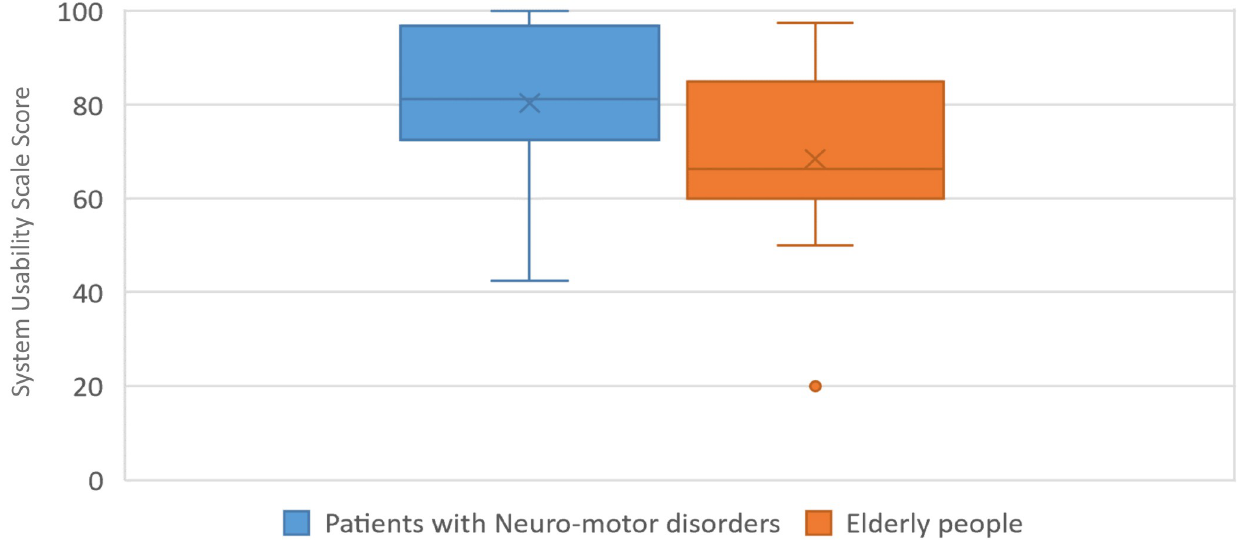
Fig 9. Boxplot distribution of SUS assessment of both